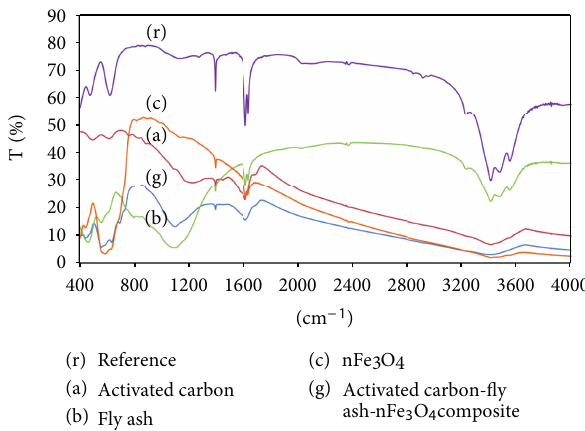
Activated carbon-fly ash-nFe 3 O 4 composite Fly ash F 11: F�I� spectrum of precursors and activated carbon-�y ash-nFe